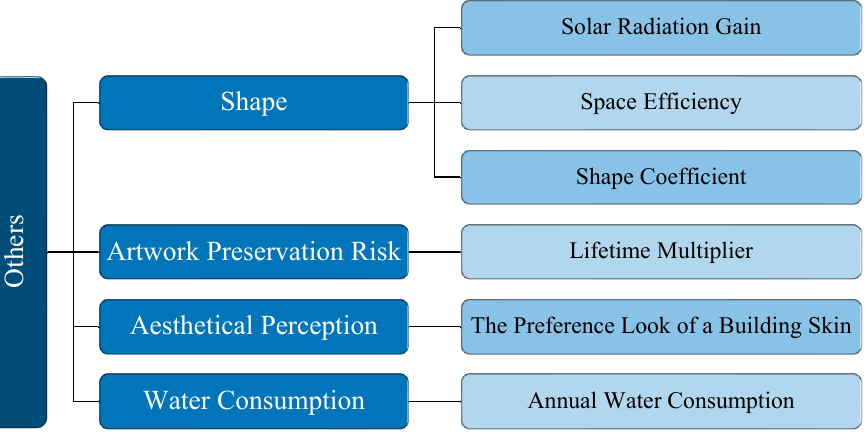
Figure 10. Other